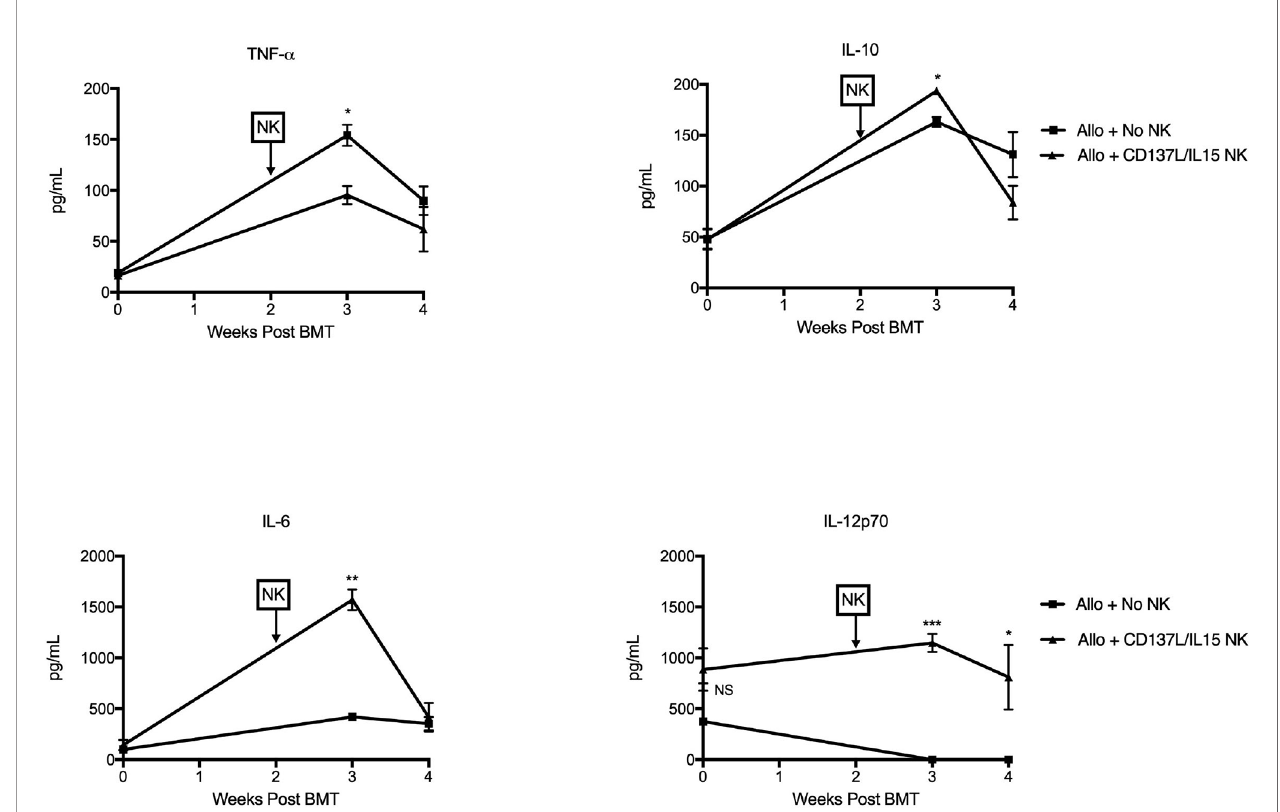
FIGURE 5 | Ex vivo CD137L/IL-15/IL-15R a expanded NK cells mediate cytokine release syndrome in vivo . Lethally irradiated B6AJF1 mice (H-2 b x a ) were transplanted with CD3e cell depleted BM from B6 mice (H-2 b ) on Day +0. On Day +10, 2 x 10 6 NXS2 tumor cells were inoculated into the right fl ank. On days +14- 16, hu14.18-IL-2 (IC) was administered. On Day +16, groups were infused with PBS or 2.5 x 10 6 CD137L/IL-15/IL-15R a expanded B6 NK cells. Peripheral blood was collected pre-alloHSCT, and then 3 and 4 weeks post-alloHSCT. Serum was isolated from each blood sample and all timepoints were frozen, batched and analyzed in duplicate by multiplex cytokine array. N= 5 mice/group. *p < 0.05, **p < 0.01, ***p <